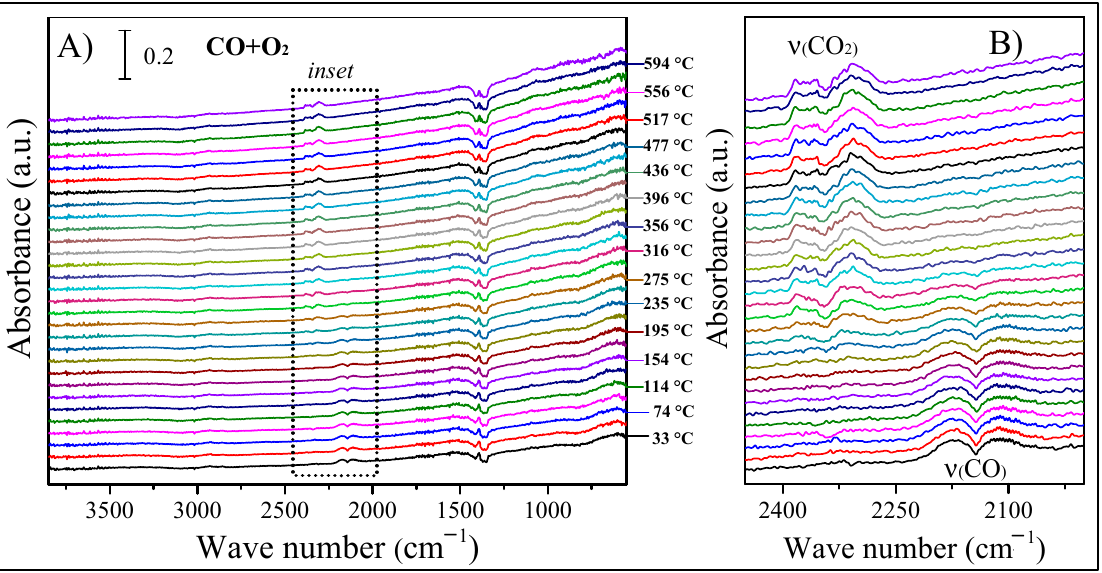
Figure 13. DRIFTS spectra obtained between 30 and 600 °C for the CO oxidation process using the LNO-600 catalyst ( A ) and the corresponding amplification of the spectral region (2475 and 2000 cm − 1 ) where the CO and CO 2 vibrational modes appear ( B ).